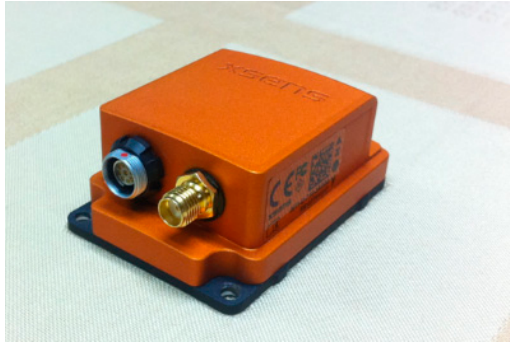
Figure 10. Xsens IMU for the foot-mounted PNS.